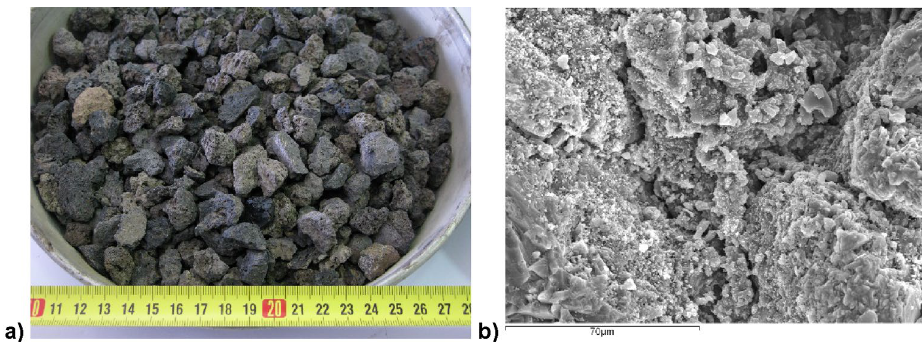
Figure 1. Detail of the B-V volcanic aggregate: ( a ) coarsest fractions (10–20 and 4–10 mm) obtained by mechanical crushing; ( b ) microstructure of this highly-vesiculated basalt (Scanning Electron Microscopy, magnification